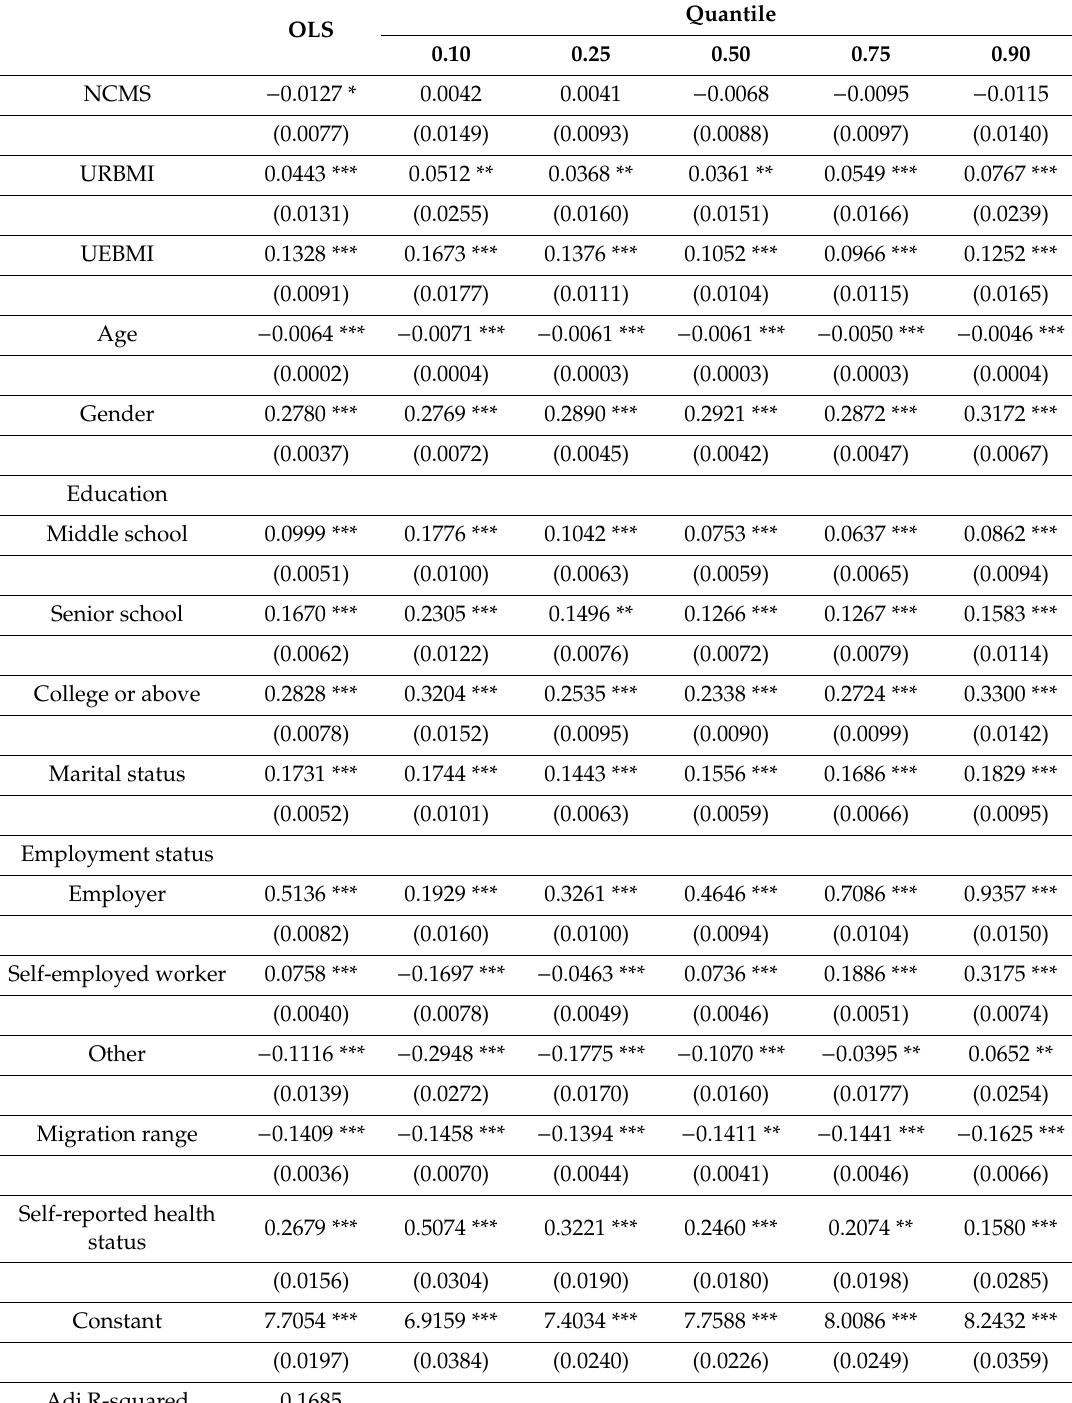
Table 3. The results of ordinary least squares (OLS) and quantile regressions